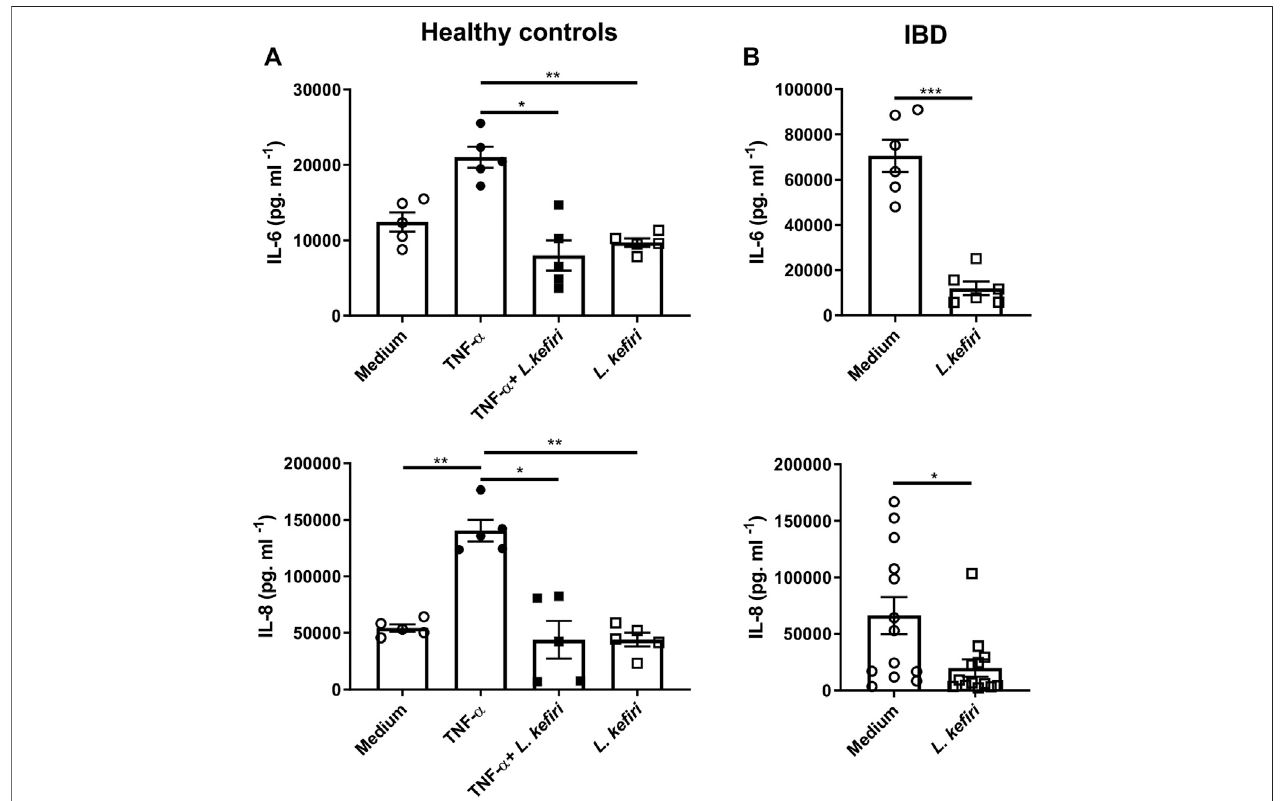
FIGURE1| Lactobacilluske fi ri modulatesthesecretionofIL-6andIL-8inorganculture (A). Biopsiesfromhealthydonors( n (cid:1) 5)wereincubatedo.n.withTNF- α , L. ke fi ri oracombinationofboth (B) .BiopsiesformIBDpatients( n (cid:1) 13)wereincubatedwithorwithout L.ke fi ri. Supernatantswerecollectedandcytokineswereassessed by ELISA. * p < 0.05, ** p < 0.01, *** p <